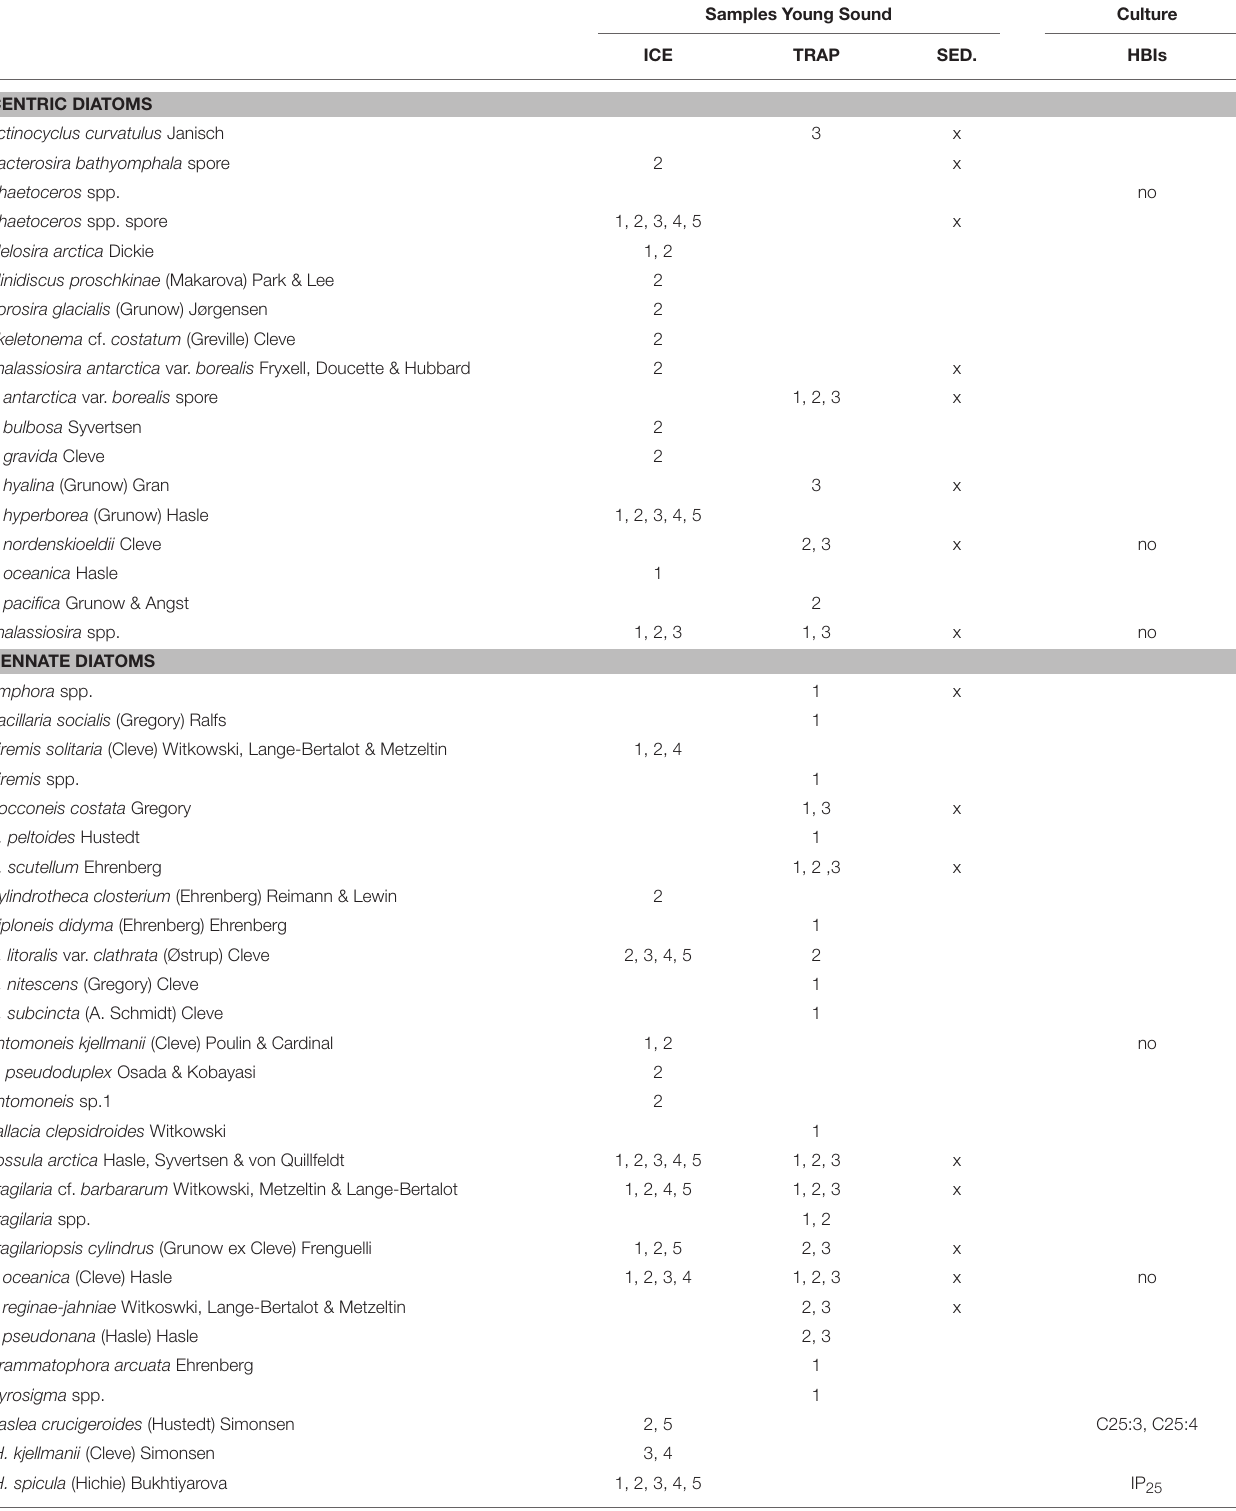
TABLE 2 | List of diatom taxa encountered in sea-ice, sediment trap and surface sediment samples from the Young Sound fjord.